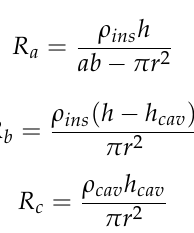
Table 6. Capacitive–Resistor Model’s Parameters (h, 2 r).